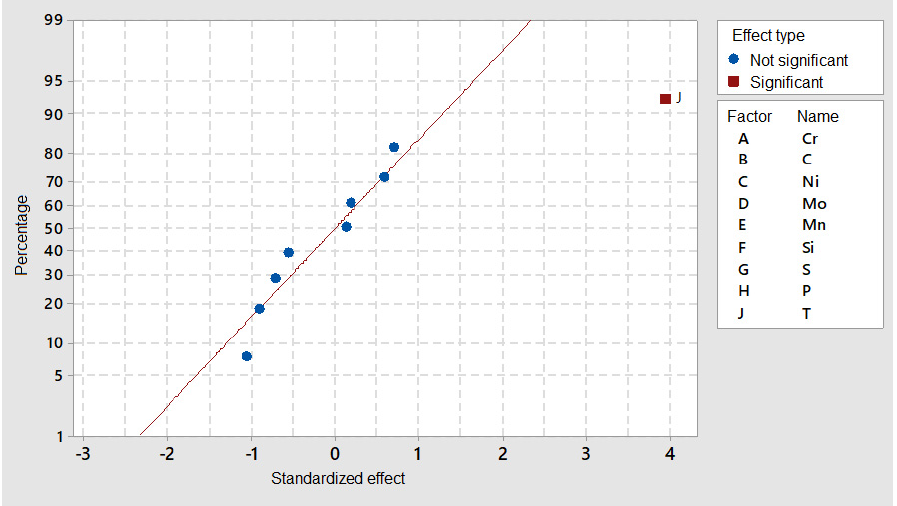
Figure 7. M 7 C 3 precipitates’ size in nanometers: standardized effects ( α = 0.05) for the DOE Ther- mocalc simulation.